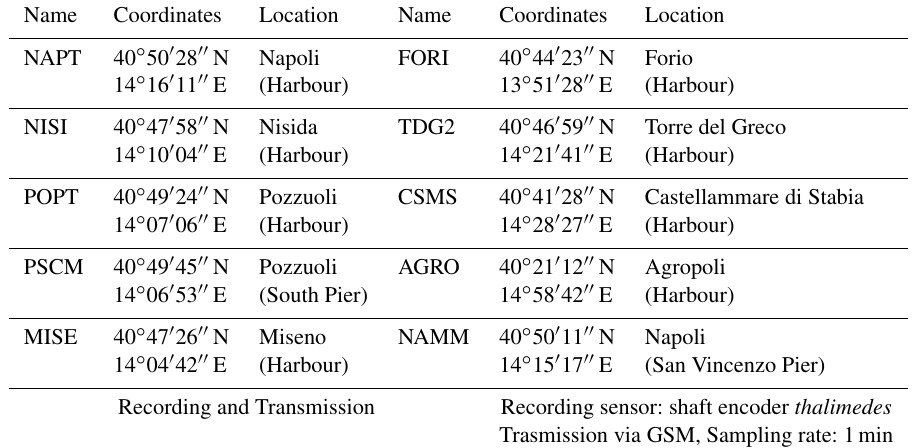
Table 1. NTGN network